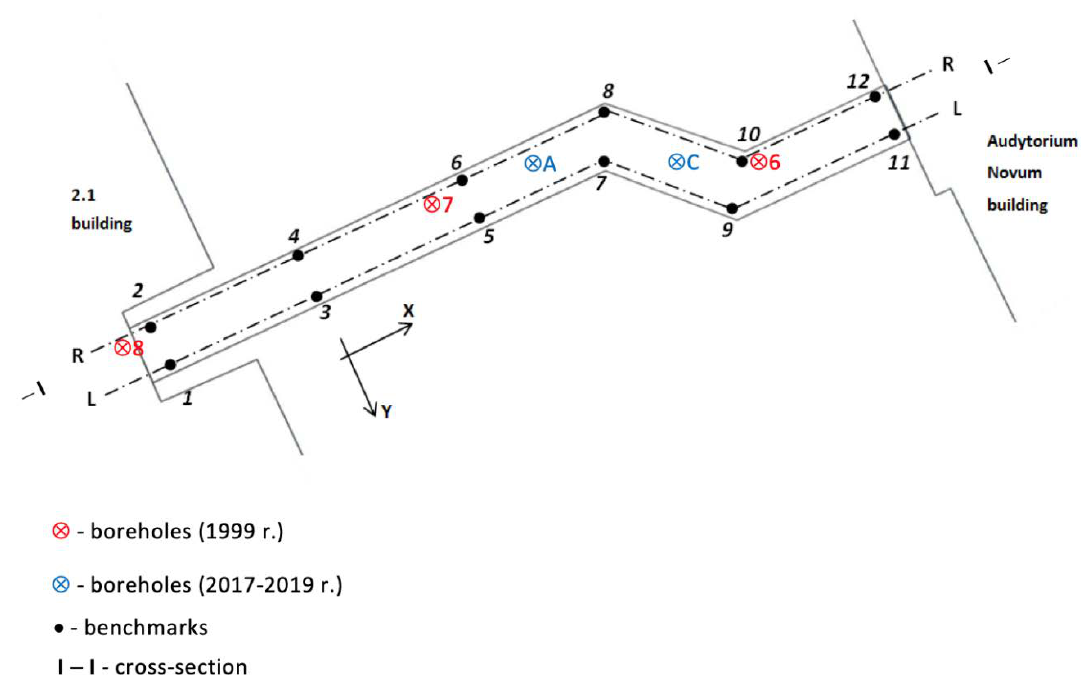
Figure 3. The network of control points.